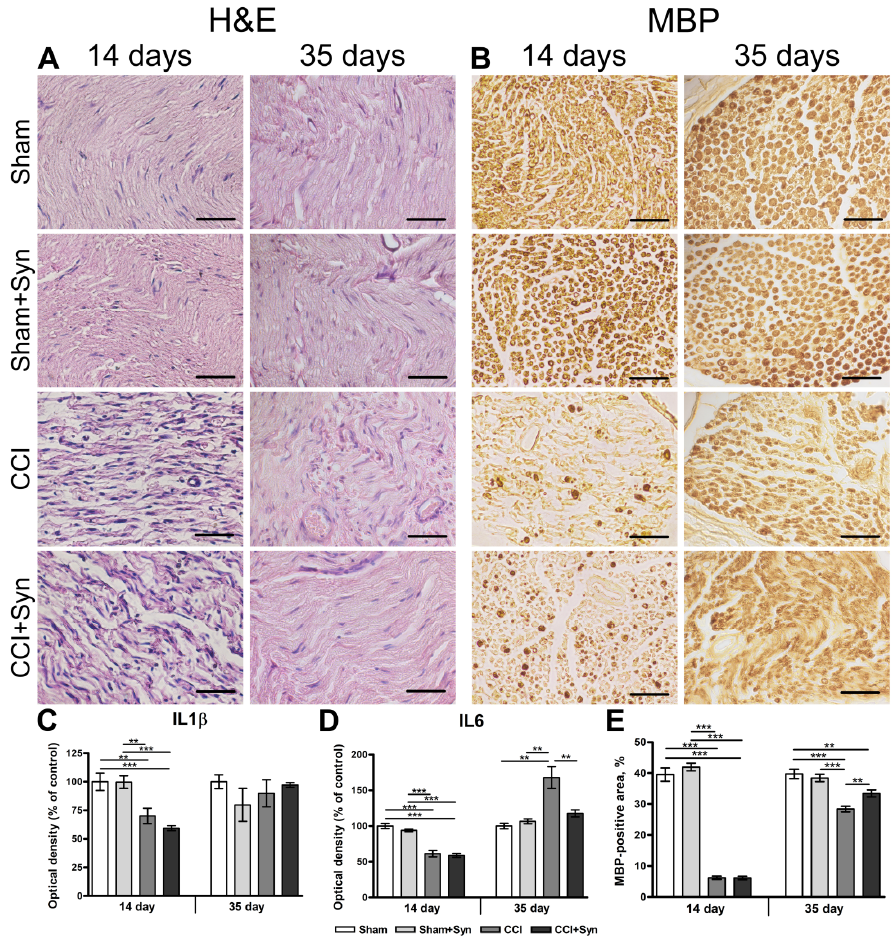
Figure 2. ( A ) The distal segment of the sciatic nerve after chronic constriction injury and following synaptamide treatment (hematoxylin–eosin staining). ( B ) Myelin basic protein (MBP) distribution in the distal segment of the sciatic nerve. Scale bar is 50 µ m. ( C ) Optical density (% of control) of interleukin-1 beta (IL-1 β ) in the sciatic nerve, mean ± SEM, n = 7 (number of animals/group) ** p < 0.01, *** p < 0.001 (one-way ANOVA, post-test Tukey). ( D ) Optical density (% of control) of interleukin-6 (IL-6) in the sciatic nerve, mean ± SEM, n = 7 (number of animals/group). ( E ) The staining area (% of total area of the nerve) of MBP-positive structures in the sciatic nerve, mean ± SEM, n = 7 (number of animals/group) ** p < 0.01, *** p < 0.001 (one-way ANOVA, post-test Tukey). “Sham”—sham-operated animals that received vehicle treatment; “Sham + Syn”—sham-operated rats that underwent synaptamide administration; “CCI”—animals with chronic constriction injury of the sciatic nerve that received vehicle treatment; “CCI + Syn”—synaptamide-treated rats with chronic constriction injury of the sciatic nerve that underwent synaptamide